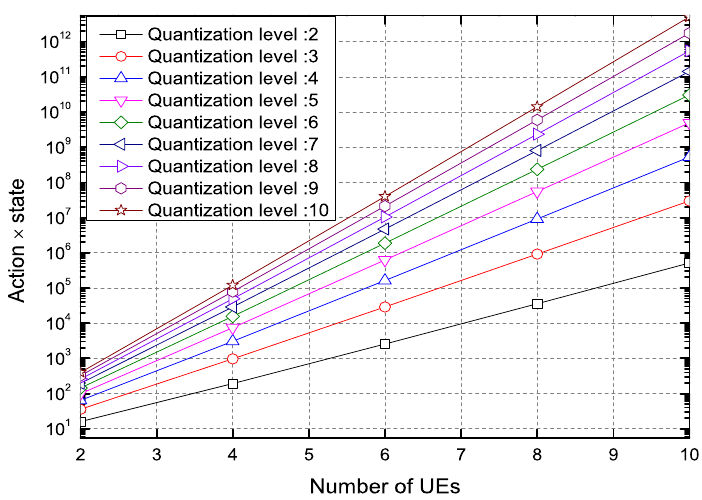
Figure 3. The ( action × state ) space versus number of user equipment (UEs).